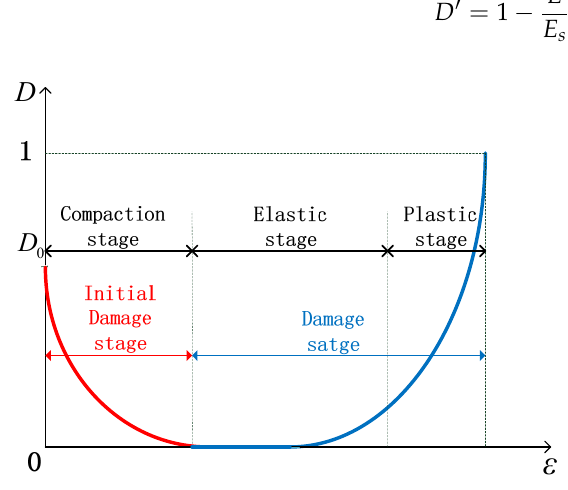
Figure 9. Damage variables vary with strain diagram.